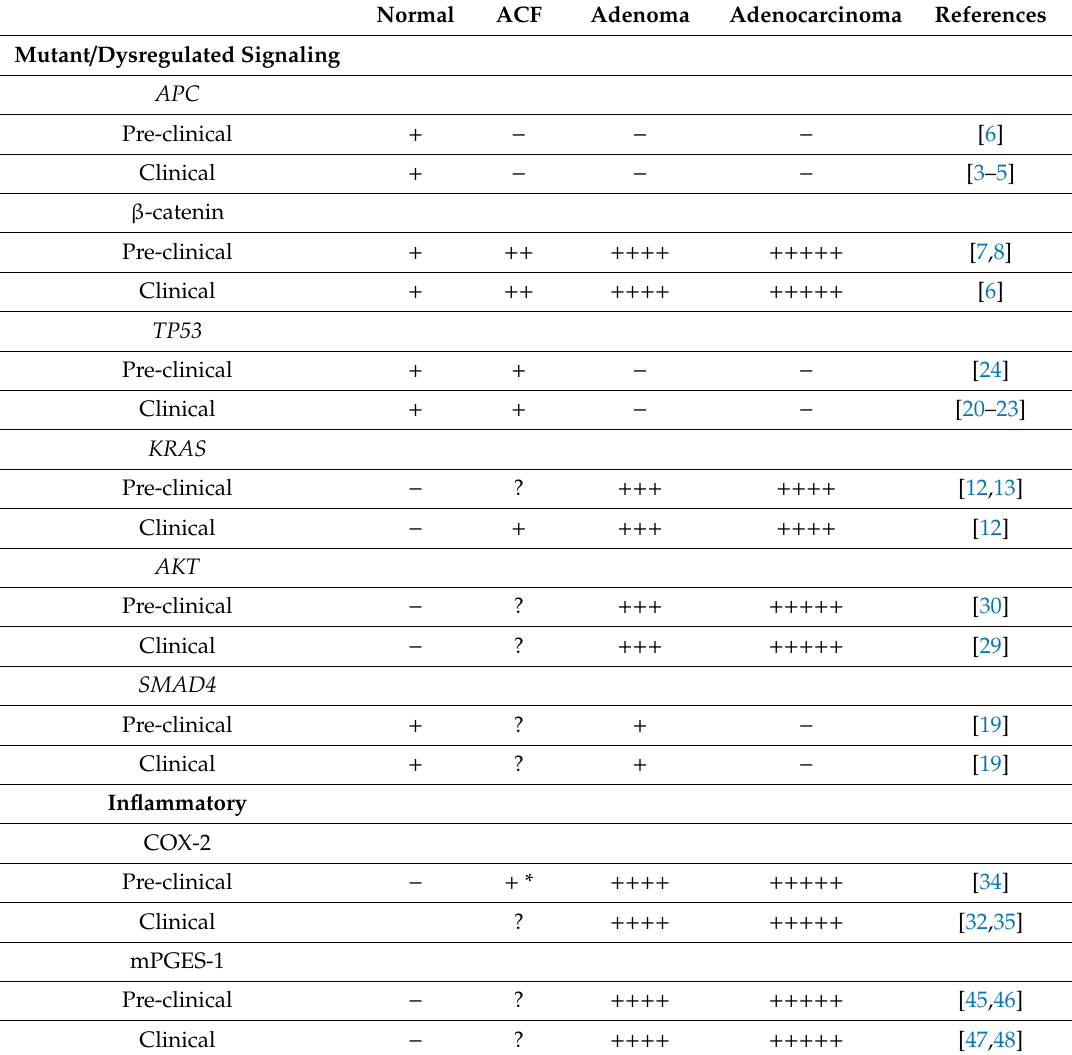
Table 1. Expression status of molecular targets at di ff erent stages from initiation to progression of colorectal cancer